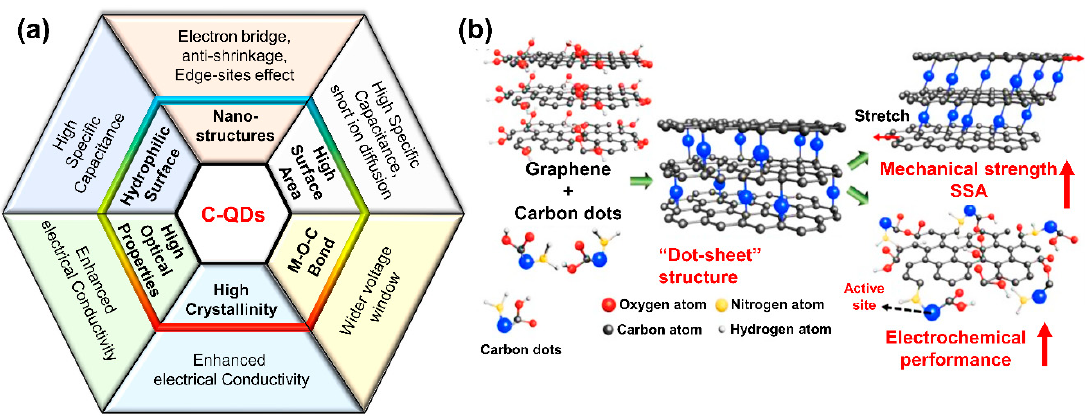
Figure 5. ( a ) A schematic showing the figure-of-merits of C-QDs composites for Supercapacitor (SC) applications that should be pursued and ( b ) a schematic illustration of the dot-sheet porous structure that consists of graphene and carbon dots: reproduced from Reference [115]. Copyright Royal Chemistry Society, 2018.